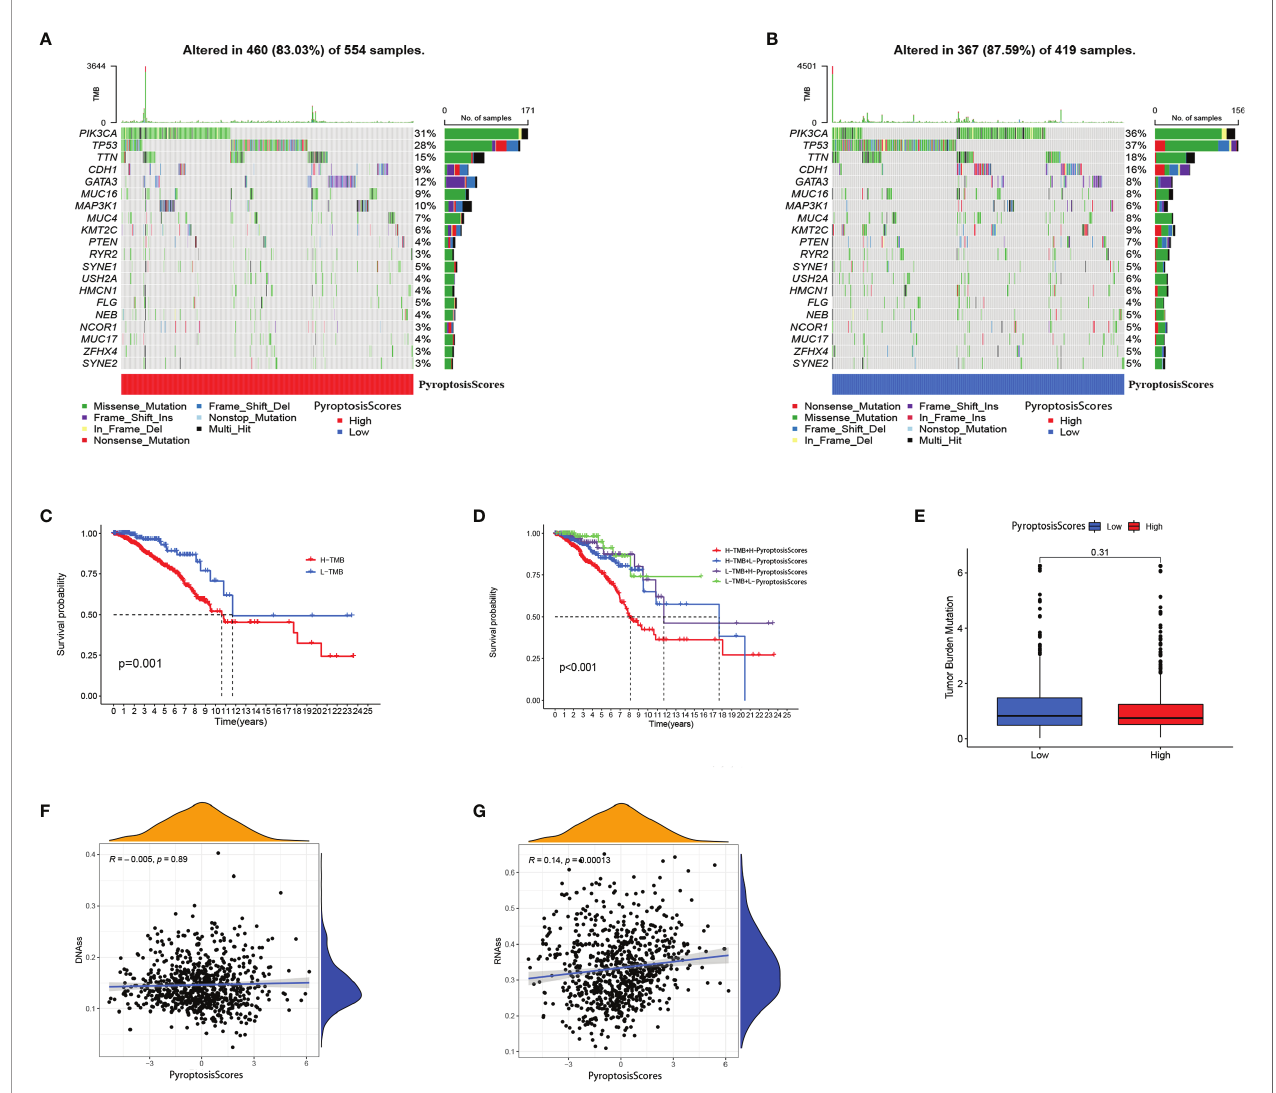
FIGURE 7 | Characteristics of tumor somatic mutation in different PyroptosisScore groups. (A) Waterfall plot of tumor somatic mutation created by groups with a high PyroptosisScore. (B) The waterfall plot of tumor somatic mutation created by groups with a low PyroptosisScore. (C) Kaplan – Meier curves were used to perform survival analyses for patients with low and high TMB. (D) The overall survival of patients was strati fi ed by both PyroptosisScore and TMB using Kaplan – Meier curves. (E) The TMB level was higher in the low PyroptosisScore group. There was no signi fi cant correlation between DNAss (F) , RNAss (G) , and